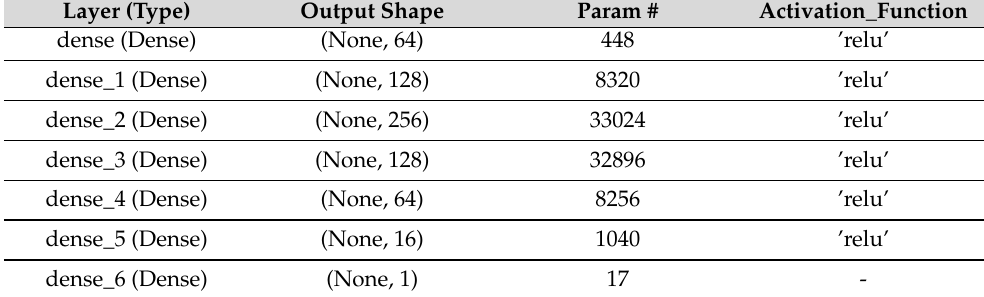
Table 5. Deep layer neural network structure to make an irradiance prediction model. Layer (Type) Output Shape Param # Activation_Function dense (Dense) (None, 64) 448